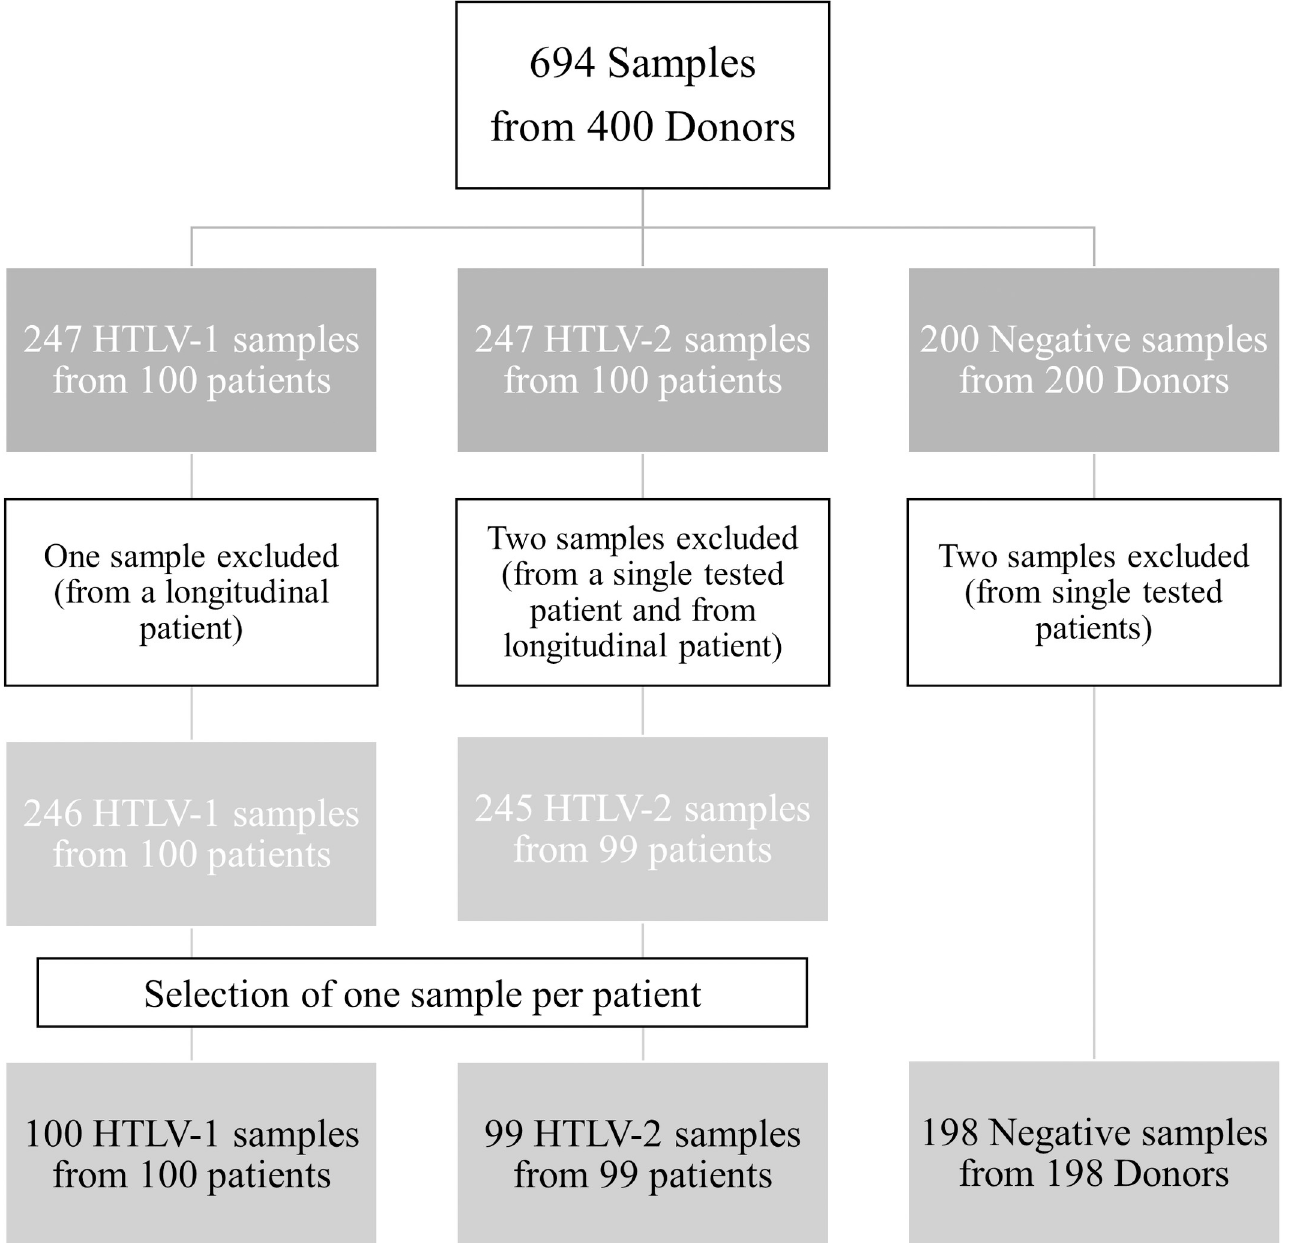
Fig 1. HOST Cohort description. The tree represents the distribution of the number of samples within the HOST cohort within the three categories of negative, HTLV-1, and HTLV-2